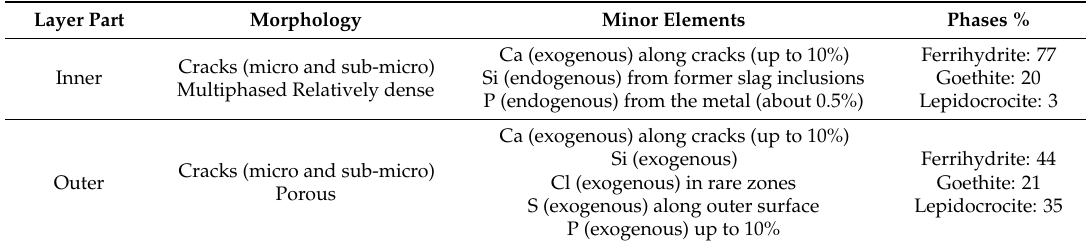
Figure 6. Quantitative µRS maps on a corrosion product layer containing goethite, ferrihydrite, and lepidocrocite. The dot line on the schematic view corresponds to the average limit between the inner sublayer (a) and outer sublayer (b). Table 2. Summing up of the characterization results.